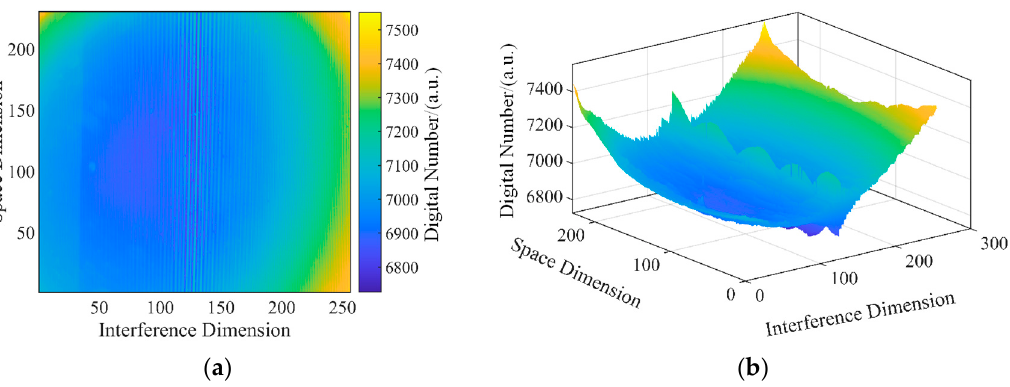
Figure 11. ( a ) Two-dimensional interferogram of 338 K radiation source. ( b ) Three-dimensional surface of the